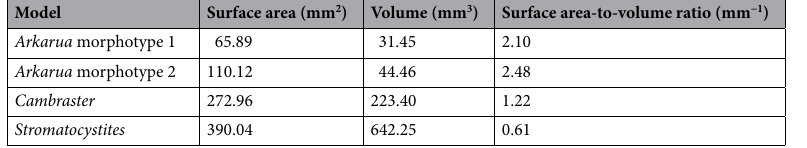
Table 1. Surface area, volume and surface area-to-volume ratios for digital models of Arkarua , Cambraster and Stromatocystites